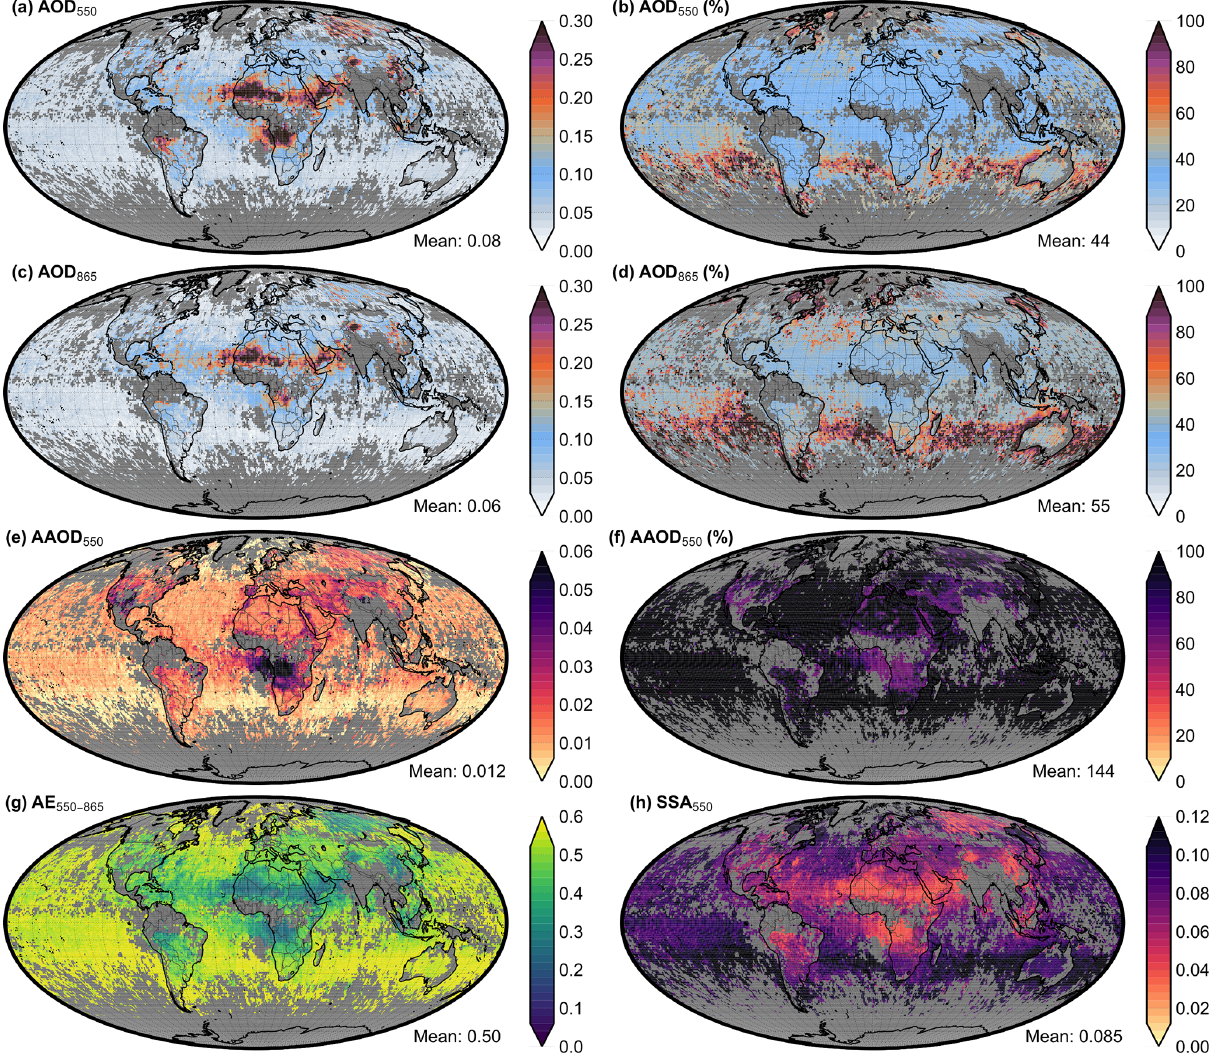
Figure 1. The uncertainty and the relative uncertainty of POLDER for AOD 550 (a, b) AOD 865 (c, d) and AAOD 550 (e, f) and the uncertainty for AE 550 − 865 (g) and SSA 550 (h) averaged over the period 20 July to 28 August 2006. The global mean of each variable is denoted in the bottom-right corner for each